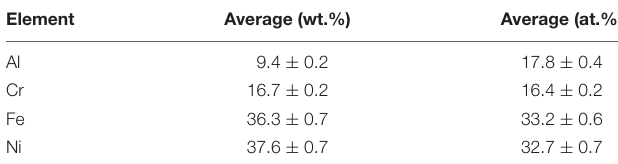
TABLE 2 | Chemical composition of the powder measured by